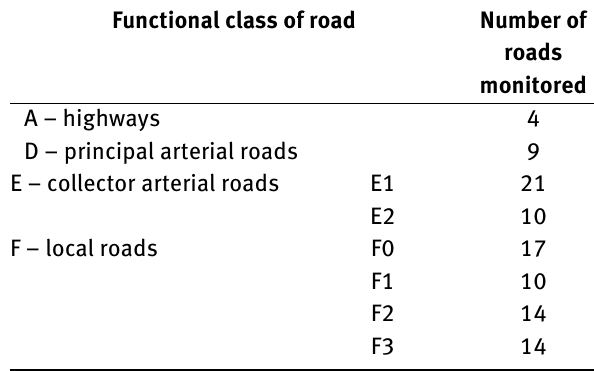
Table 2: Scheme of the noise monitoring